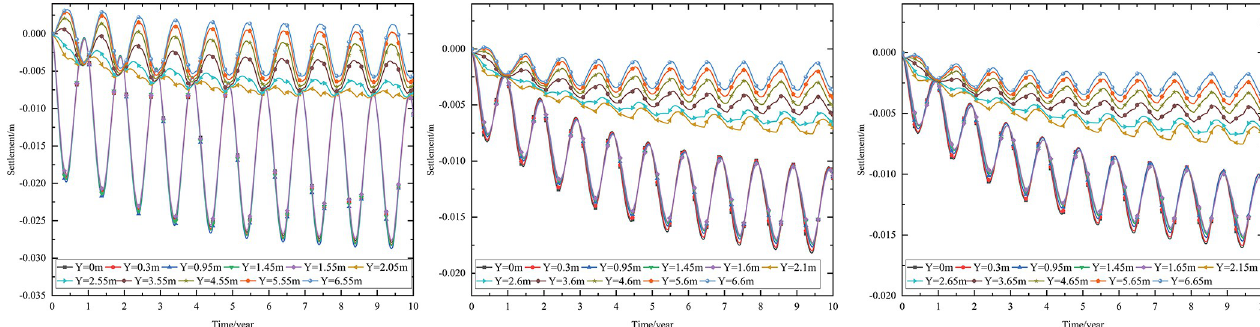
Fig 14. Settlement-time curves of pavement center at the installation layer thickness of (a) 0.10 m, (b) 0.15 m, and (c) 0.20 m.